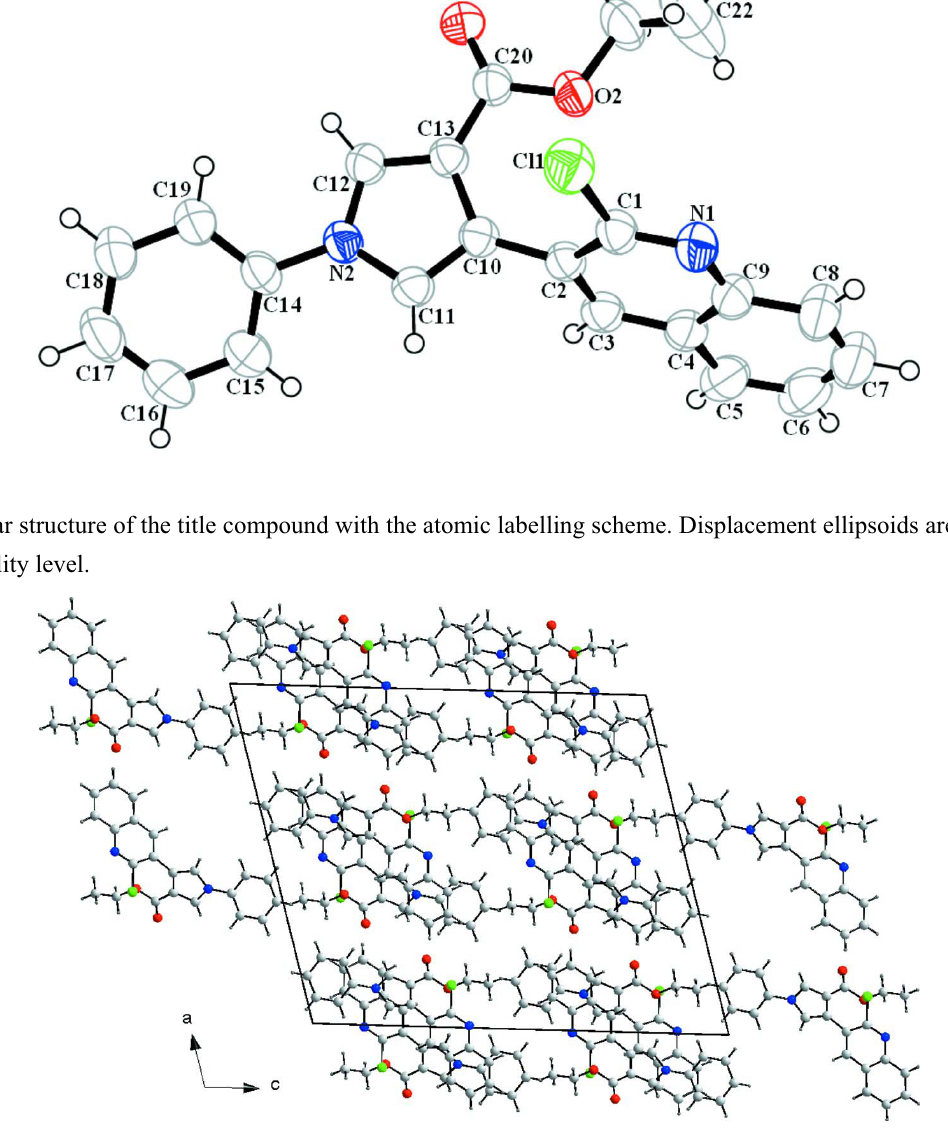
Figure 2 Packing diagram of the title compound viewed along the b